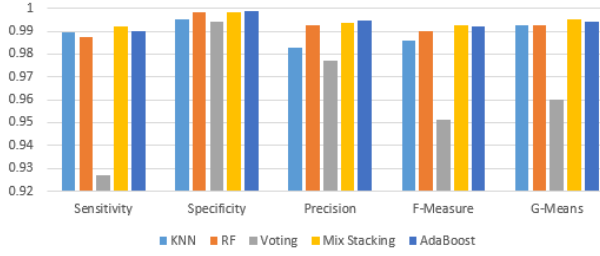
Figure 4. Comparison chart of algorithms when classifying DoS on UNSW-NB15